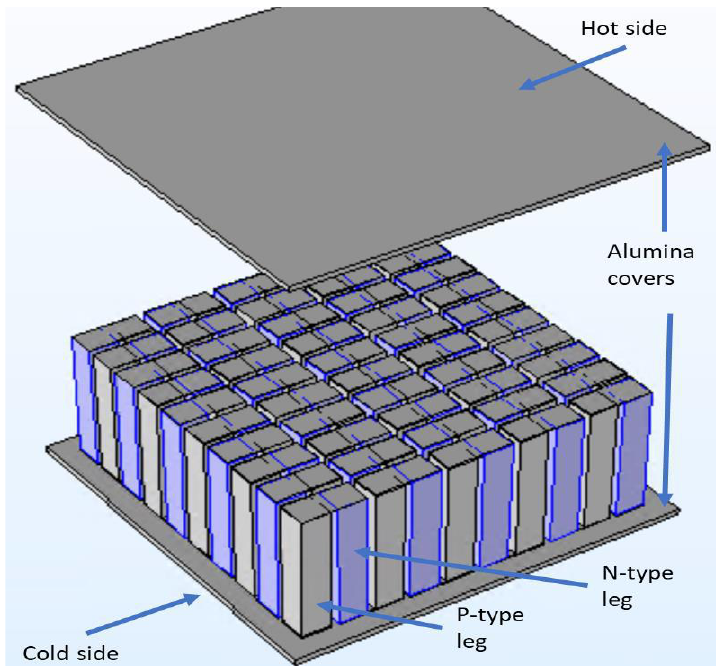
Figure 2. Design of a standard thermoelectric module. The top cover is exploded out to give a clear view of the makeup of the module. In reality, it would sit directly above the legs, just as the bottom plate sits directly below them.